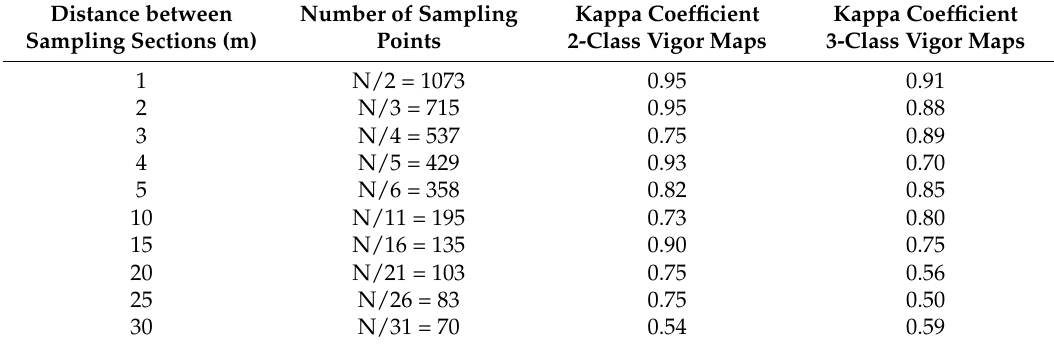
Table 1. Analysis of the correlation between the LAI classified maps obtained by on-the-go scanning (with a total of 2146 sampling points, N) and those obtained discontinuously scanning according to various sampling